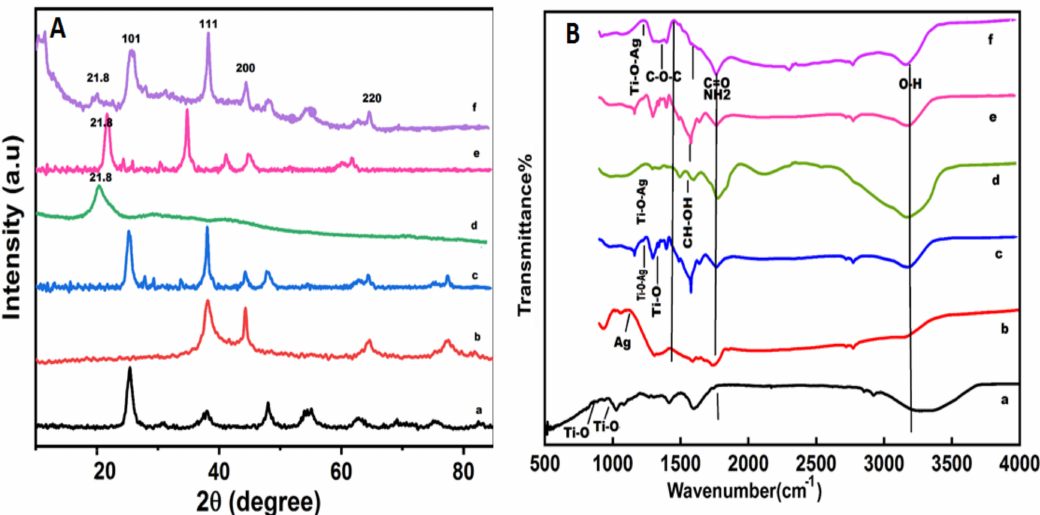
Figure 3. XRD profiles ( A ) and Fourier Transform Infrared spectroscopy (FTIR) spectrums of eco-friendly prepared nanoformulations ( B ) are shown, Key: ( a ) TiO 2 NPs, ( b ) AgNPs, ( c ) Ag/TiO 2 nanocomposite, ( d ) chitosan (CS) nanoparticles (NPs), ( e ) unloaded Ag/TiO 2 /CS nanohybrid, and ( f ) CIP-Ag/TiO 2 /CS